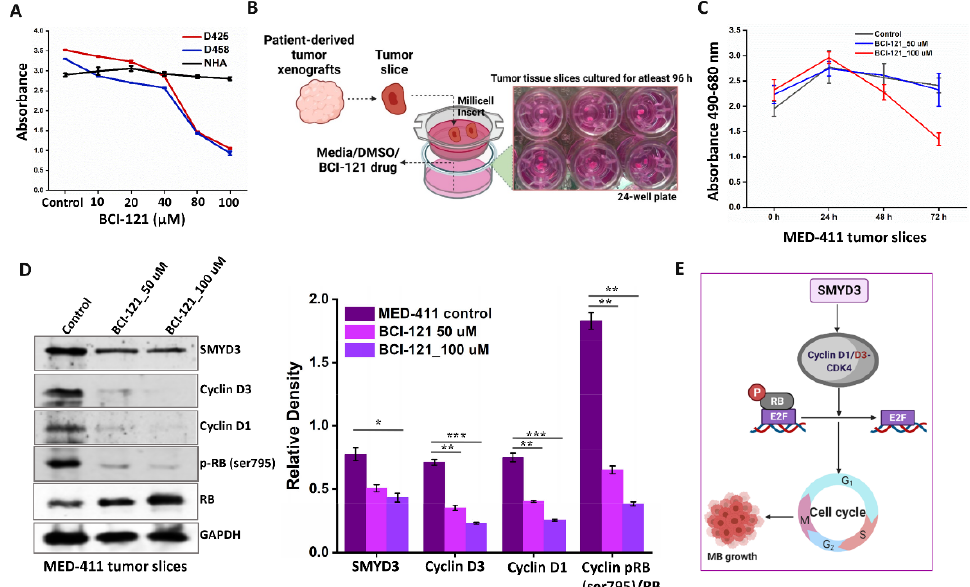
Figure 10. BCI-121 impairs MB cell viability in vitro and ex vivo. ( A ) MTT assay of D425, D458, and NHA cell lines treated with BCI-121. ( B ) Scheme showing patient-derived tumor xenografts (PDX) in the ex vivo tissue slice culture following treatment with BCI-121. ( C ) Graph depicting absorbance values (490–680 nm) of MED411-FH tumor tissue slices treated with or without BCI-121 over days 0, 1, 2, and 3. ( D ) Protein expression levels of SMYD3, cyclin D3/D1, and RB/pRB in the MED411 tumor tissue lysates treated with or without BCI-121 (50 and 100 µ M). Graph depicting the densitometry analysis for the proteins in the western blot in the control and treated MED-411 tumor slices. The ratio of the relative level of phosphorylated (p) RB to total RB is plotted for each experimental condition. ( E ) Scheme representing SMYD3 regulation of cyclin D1/D3, its effect on RB phosphorylation, and progression of the cell cycle. The statistical significance * p < 0.05, ** p < 0.01, *** p <